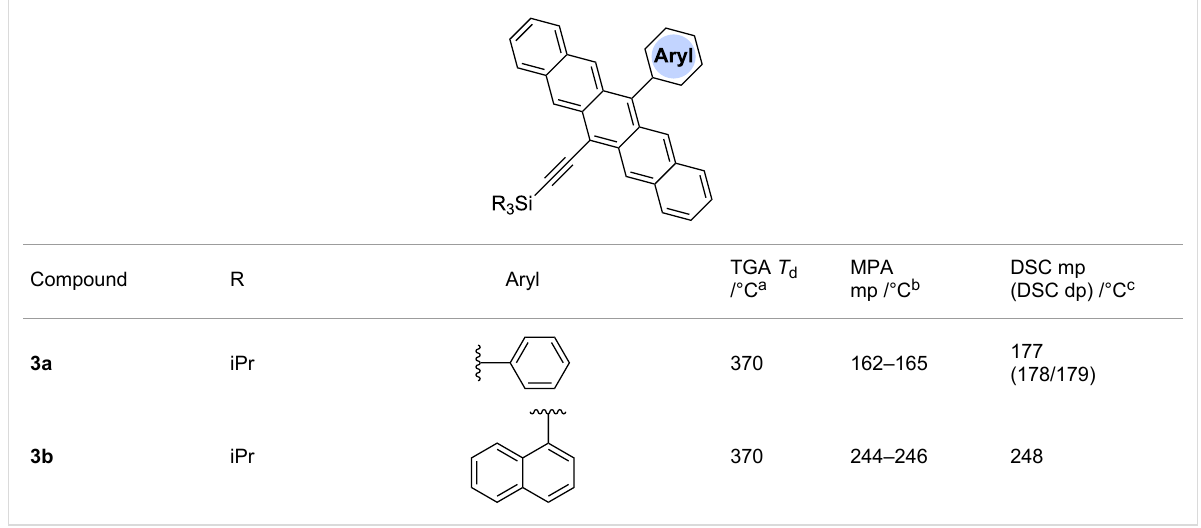
Table 2: Thermal properties of a representative selection of pentacenes.